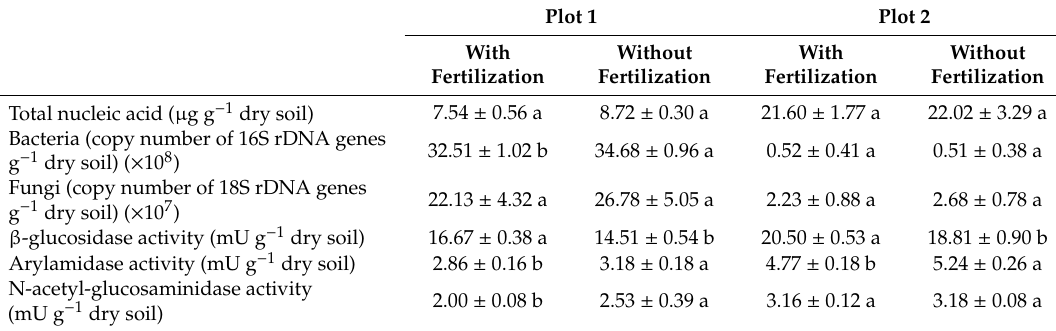
Plot 1 Plot 2 With Without With Without Fertilization Fertilization Fertilization Fertilization 32.51 ± 1.02 b 22.13 ± 4.32 a